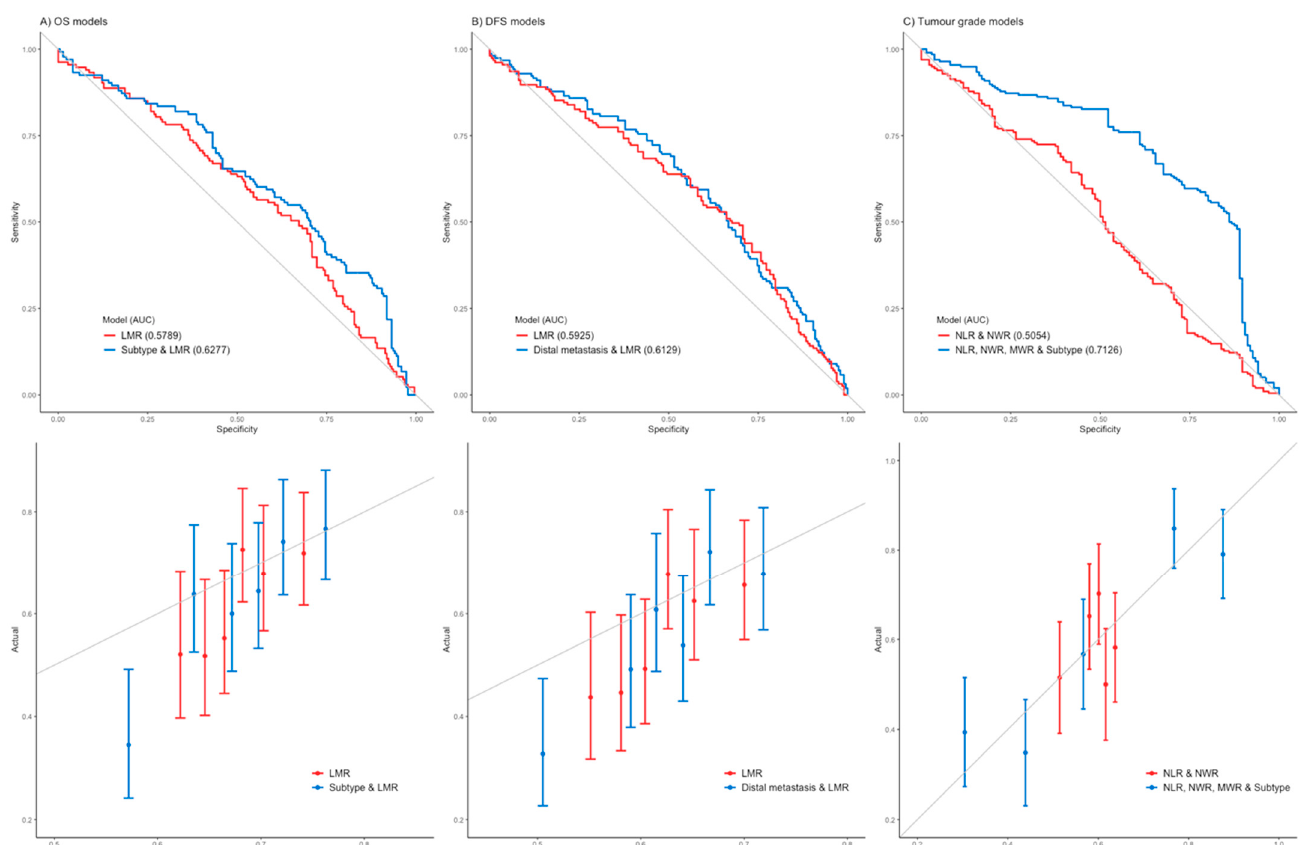
Figure 2. Multivariate model performance, top, and calibration, bottom. ( A ) Models for OS at 3 years, including LMR, and breast cancer subtype and LMR models. ( B ) Models for DFS at 3 years, including LMR, and distal metastasis and LMR. ( C ) Models for tumors grade at 3 years, including LMR and NWR, and NLR and NWR, MWR and breast cancer subtype models.